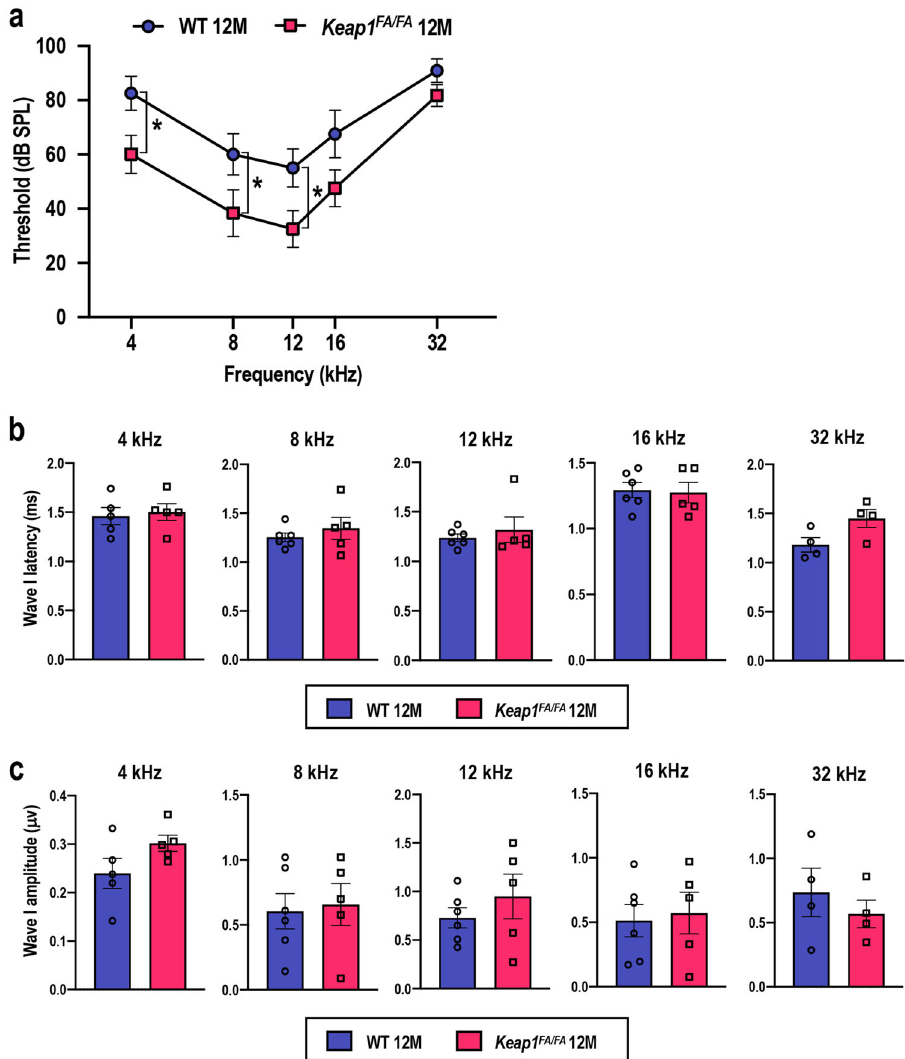
Fig. 9 Comparison of ABR of the WT and Keap1 FA/FA mice at 12 months of age. ABR thresholds ( a , n = 6 for each group), ABR wave I latencies ( b , n = 6 for WT mice and n = 5 for Keap1 FA/FA mice), and ABR wave I amplitudes ( c , n = 6 for WT mice and n = 5 for Keap1 FA/FA mice) of the WT and Keap1 FA/FA mice at the age of 12 months. One and two WT mice that exhibited ABR thresholds above 100 dB SPL at 4 and 32 kHz, respectively, were omitted from the waveform analysis shown in b and c . Likewise, one Keap1 FA/FA mouse that exhibited an ABR threshold above 100 dB SPL at 32 kHz was omitted from the waveform analysis shown in b and c . The data represent the mean ± SE. * P < 0.05. Unpaired two-tailed Student ’ s t -test was applied. The samples of the WT mice at 12 months of age are the same as those shown in Fig.